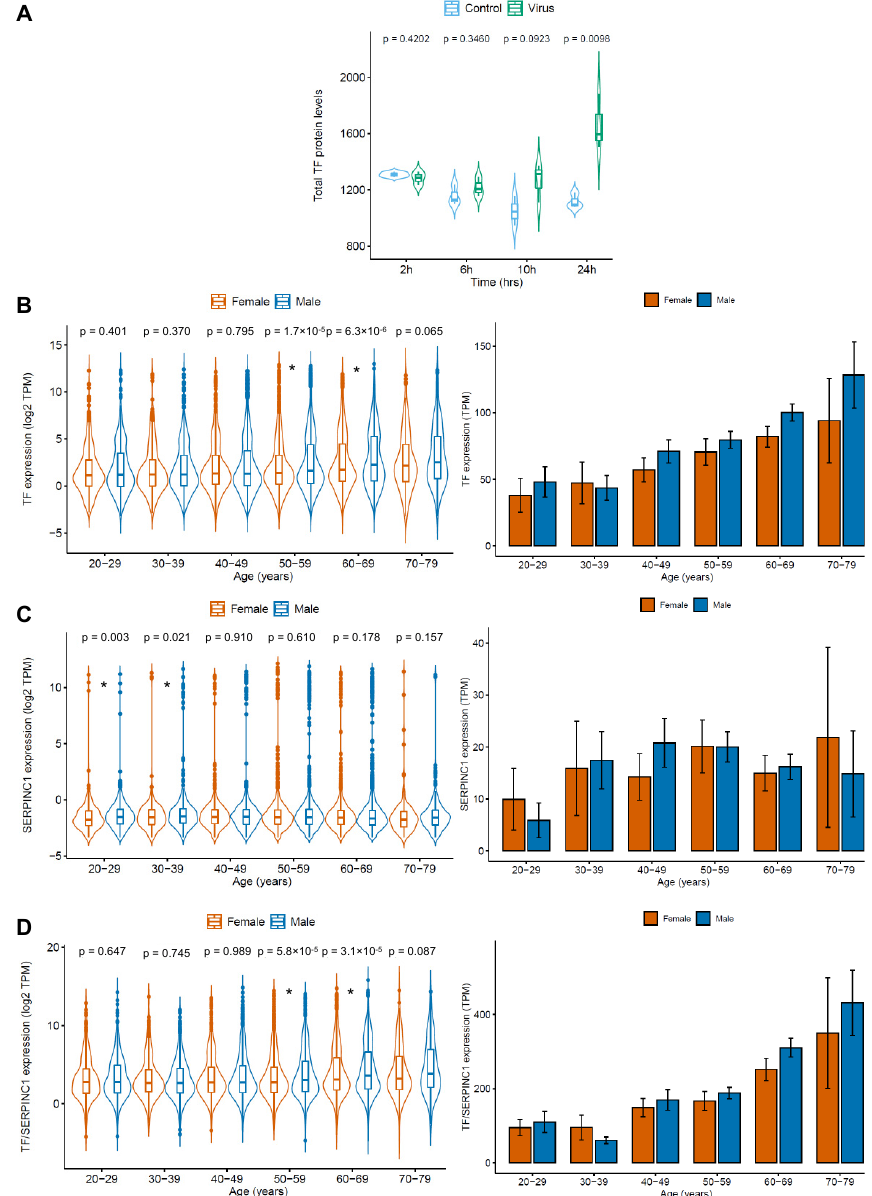
Figure 2. SARS-CoV-2-induced (derived from [9]) transferrin (TF) expression and age- and gender-specific expression of the procoagulant TF and its antagonist SERPINC1 / antithrombin based on GTEx data. Data are presented as violin blots to indicate the distribution of individual values and as bar charts to facilitate comparisons. TF displayed higher levels in SARS-CoV-2-infected cells than in non-infected cells. Moreover, TF expression and the expression ration of TF and SERPINC1 increased with age and were higher in females than in males. ( A ) TF protein abundance in uninfected (control) and SARS-CoV-2-infected (virus) Caco-2 cells. p -values are the result of a two-sided Student’s t -test. ( B ) TF expression (TPM) in females and males across six age groups. p -values were calculated using the Wilcoxon rank sum test for independent groups. ( C ) SERPINC1 expression (TPM) in females and males across six age groups. p -values were calculated using the Wilcoxon rank sum test for independent groups. ( D ) Ratio of TF / SERPINC1 expression (TPM) in females and males across six age groups. p -values were calculated using the Wilcoxon rank sum test for independent groups. * p -value <